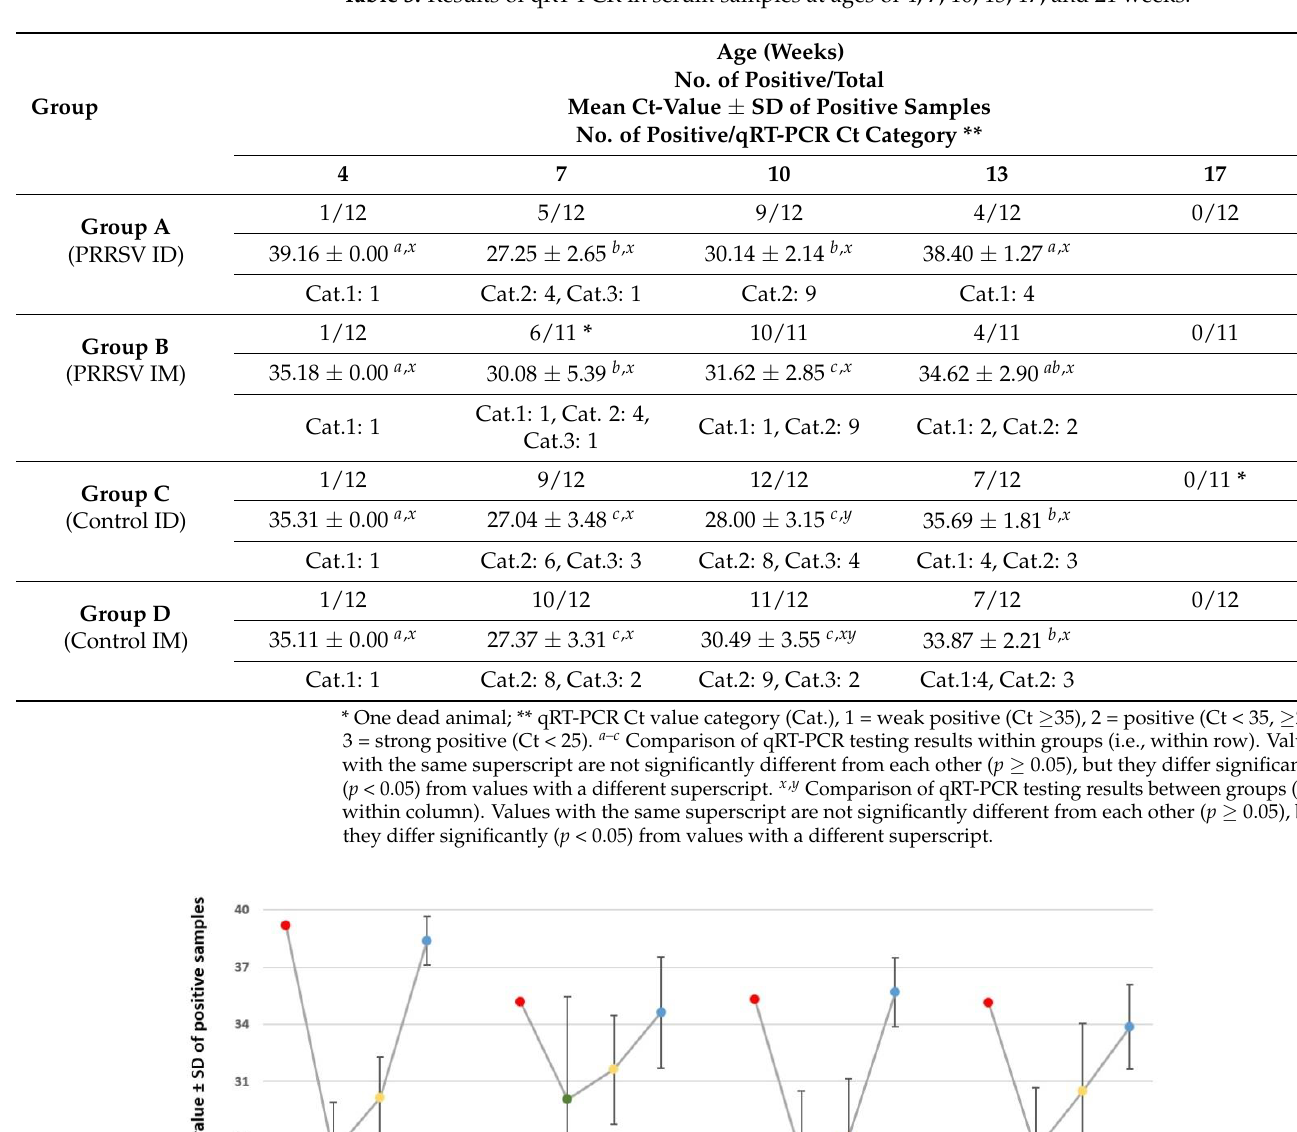
Table 3. Results of qRT-PCR in serum samples at ages of 4, 7, 10, 13, 17, and 21 weeks.